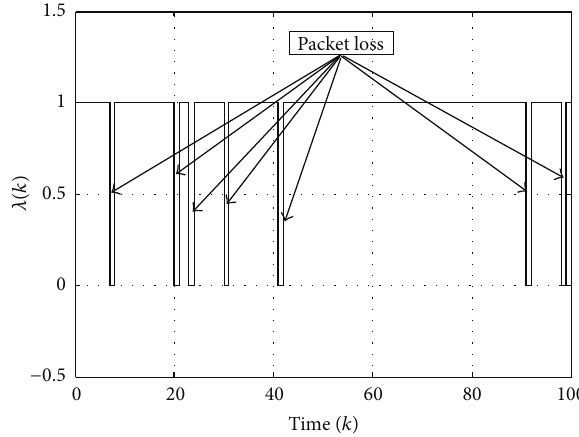
Figure 3: Residual signal 𝑟(𝑘) when 𝜌 = 1 and 𝐷 𝑓 (𝑘) = 0 .